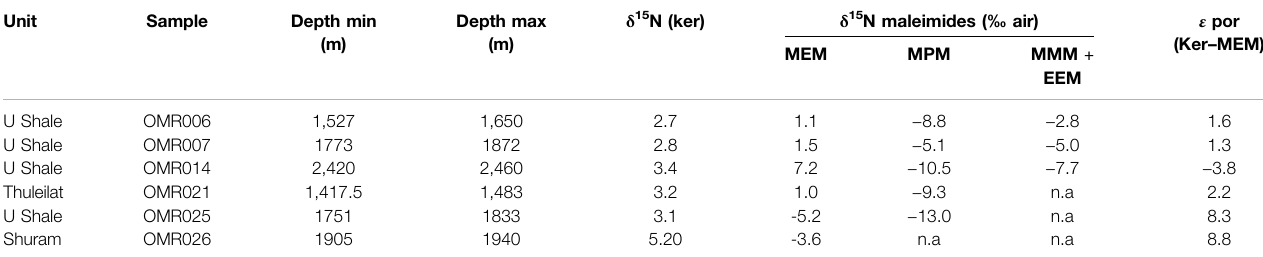
TABLE 2 | Stable nitrogen isotopic composition of kerogen and maleimides in studied samples.